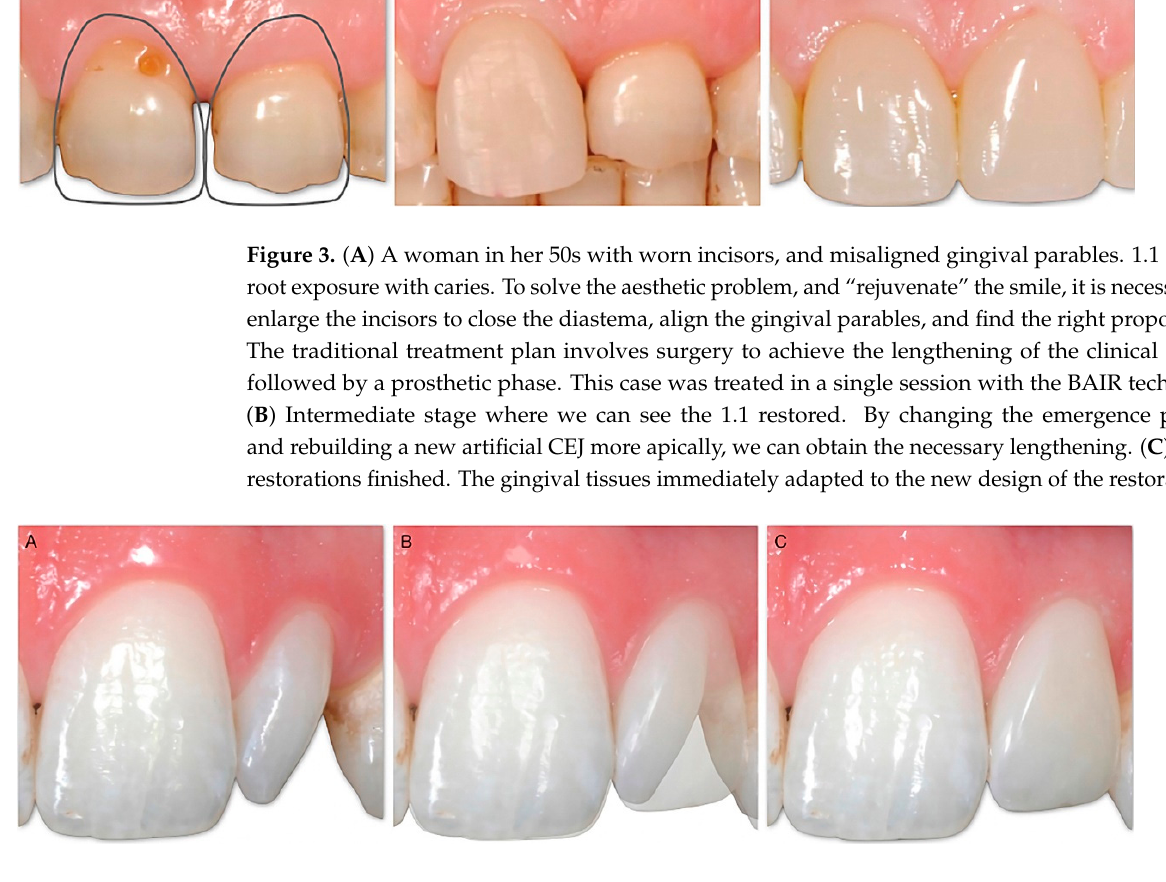
Figure 5. ( A ) 16-year-old girl at the end of orthodontic treatment. There is a noticeable disharmony between the size of the central incisors and those of the lateral incisors and canines ( A ). There are also diastemas that the patient does not like, and which make the smile unpleasant ( B ). In a single session, without the need to give anesthetic, it was possible to enlarge the microdontic teeth, close the diastemas, correct the vestibular inclination of 2.3, and, at the same time, give a better balance to the gingival parables ( C ), thus obtaining a more pleasant smile ( D ). Figure 6. 20-year-old man at the end of orthodontic treatment. The frontal sector shows small teeth, and large diastemas ( A ). To meet the aesthetic needs of the patient, it was necessary to enlarge the